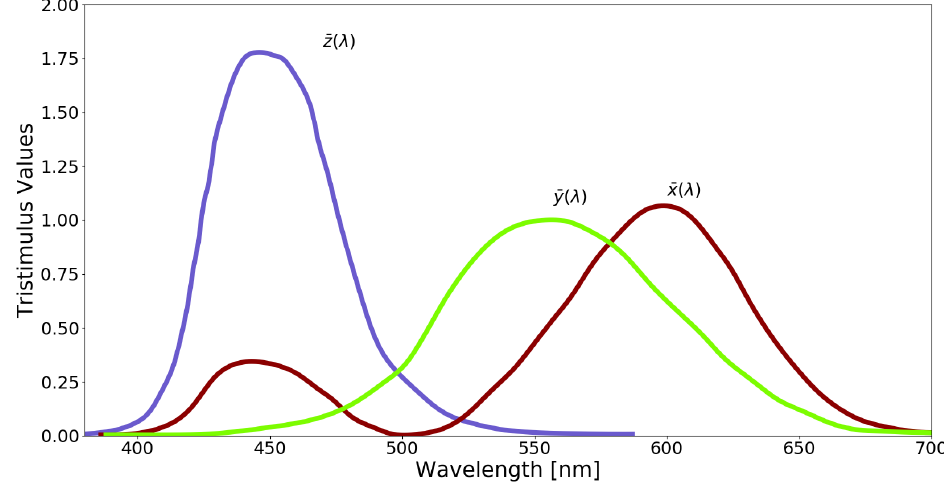
Figure 5. Spectral response of color matching functions ¯ x ( λ ) , ¯ y ( λ ) , and ¯ z ( λ )